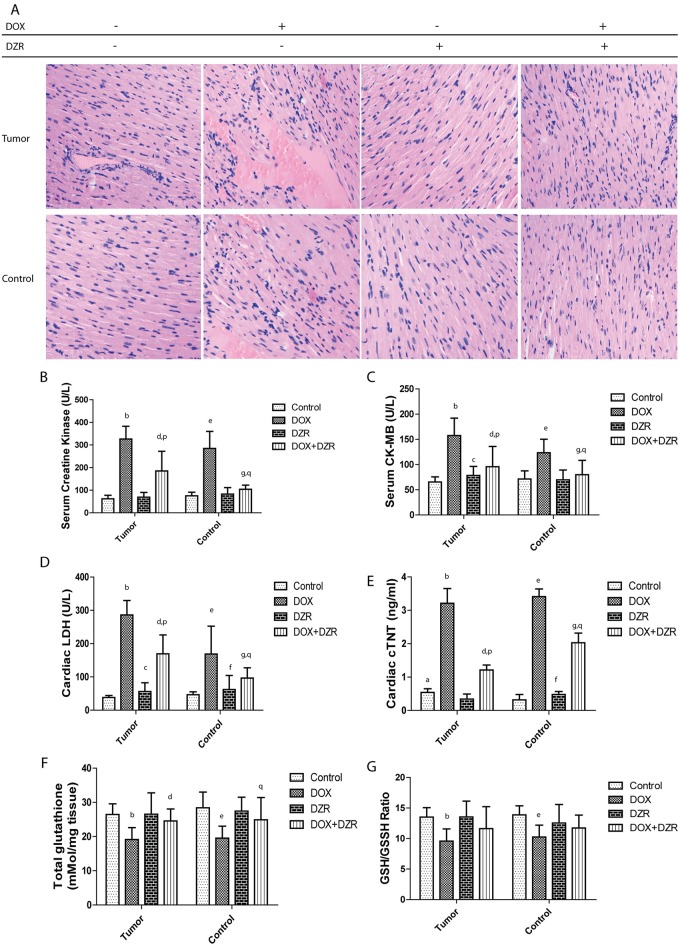
DZR protected against DOX-induced myocardial damage.Histopathology of HE staining of left ventricular walls indicated myocardial damage and cardioprotective effects of DZR(A). Magnification200x. DZR abrogated DOX-induced increase serum creatine kinase (B),CK-MB(C), cardiac LDH(D), cTNT(E), as well as decrease cardiac total glutathione (F) and GSH/GSSH ratio (G).